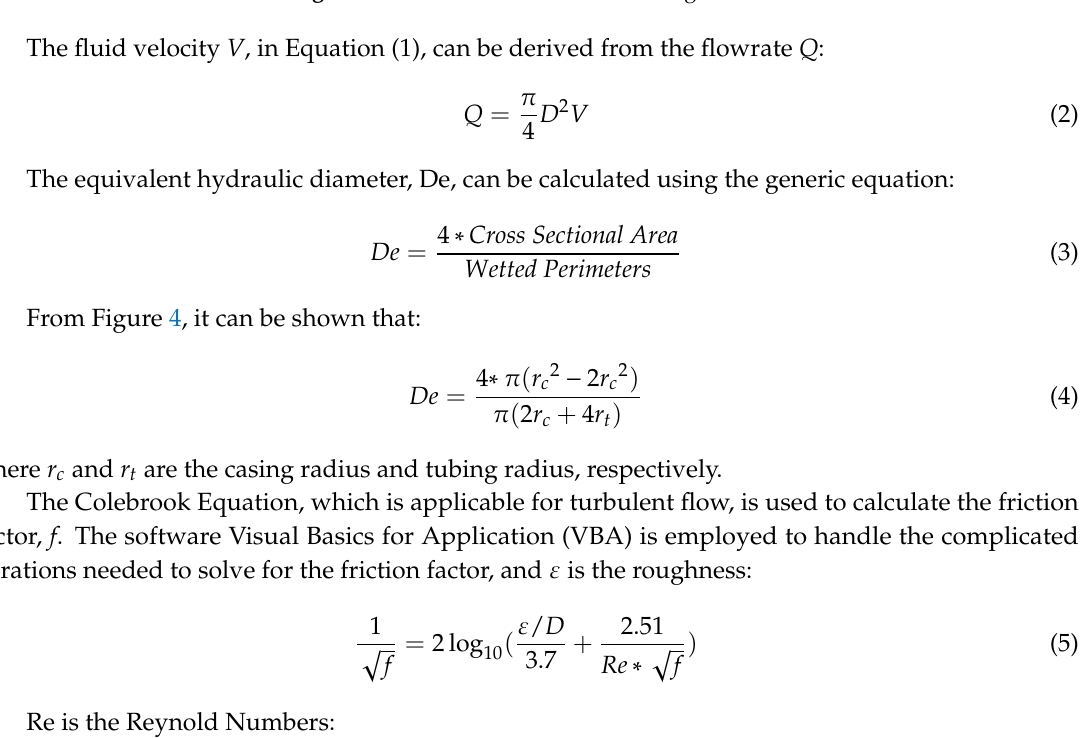
Figure 5. Cross-section of the dual strings well.